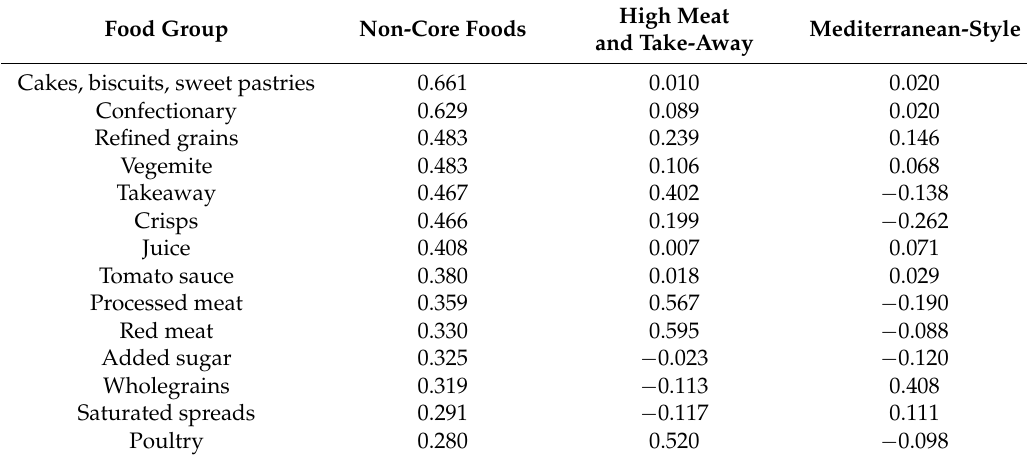
Table 2. Factor loadings for each of the identified pre-conception dietary patterns for women with and without